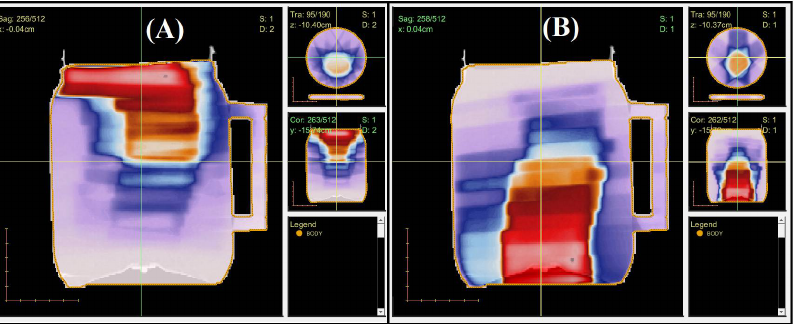
Figure 10. Three plan views of the planned dose distribution extracted from the TPS and visualized in CERR. ( A )–Cranial IMRT field. ( B )–Spinal IMRT field.